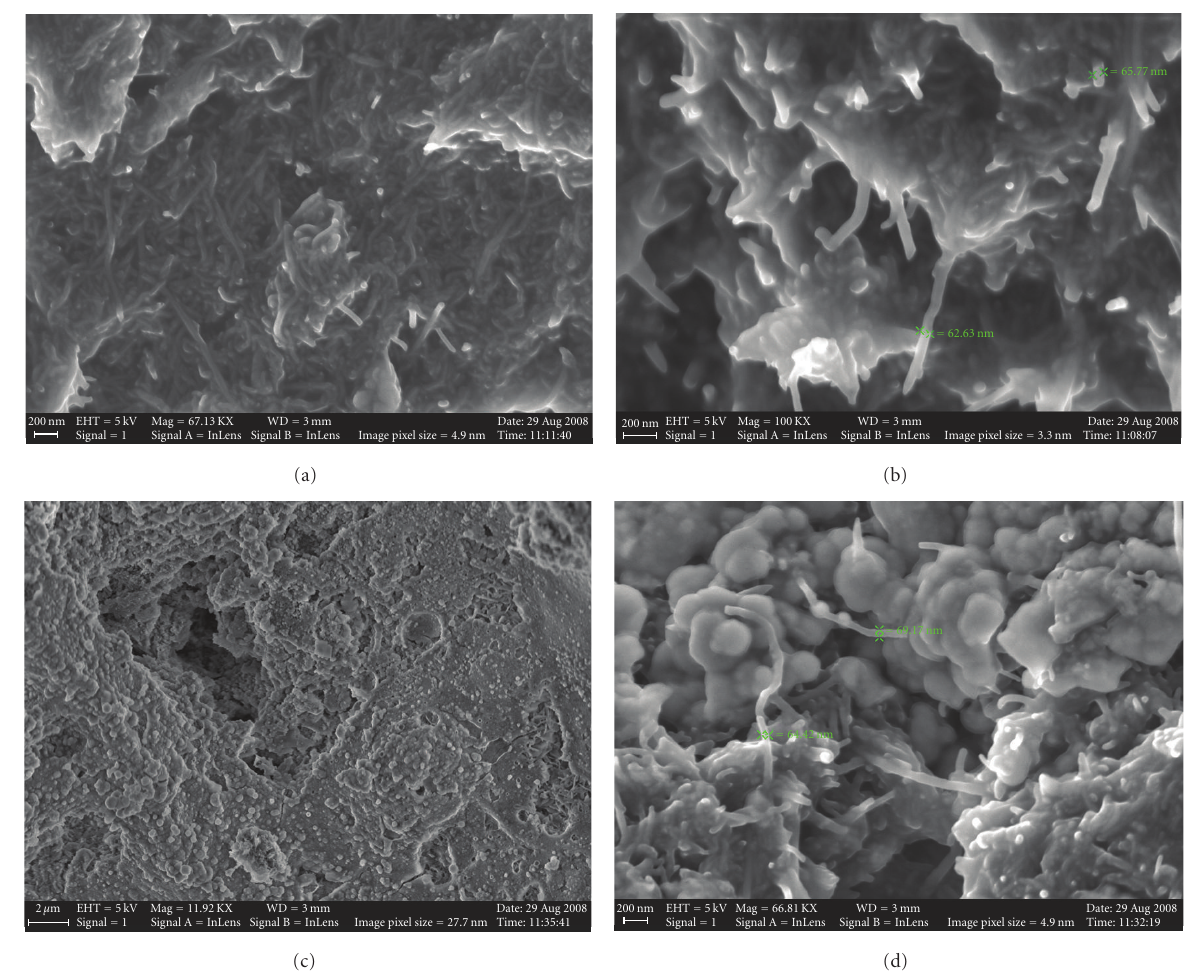
Figure 1: Scanning electron micrographs for carbon nanotube paste electrode (60% w/w) (a and b) and CNTs-AChE biosensor (c and d). Scales: (a) 200nm, (b) 200 nm, (c) 2 μ m, and (d) 200nm.